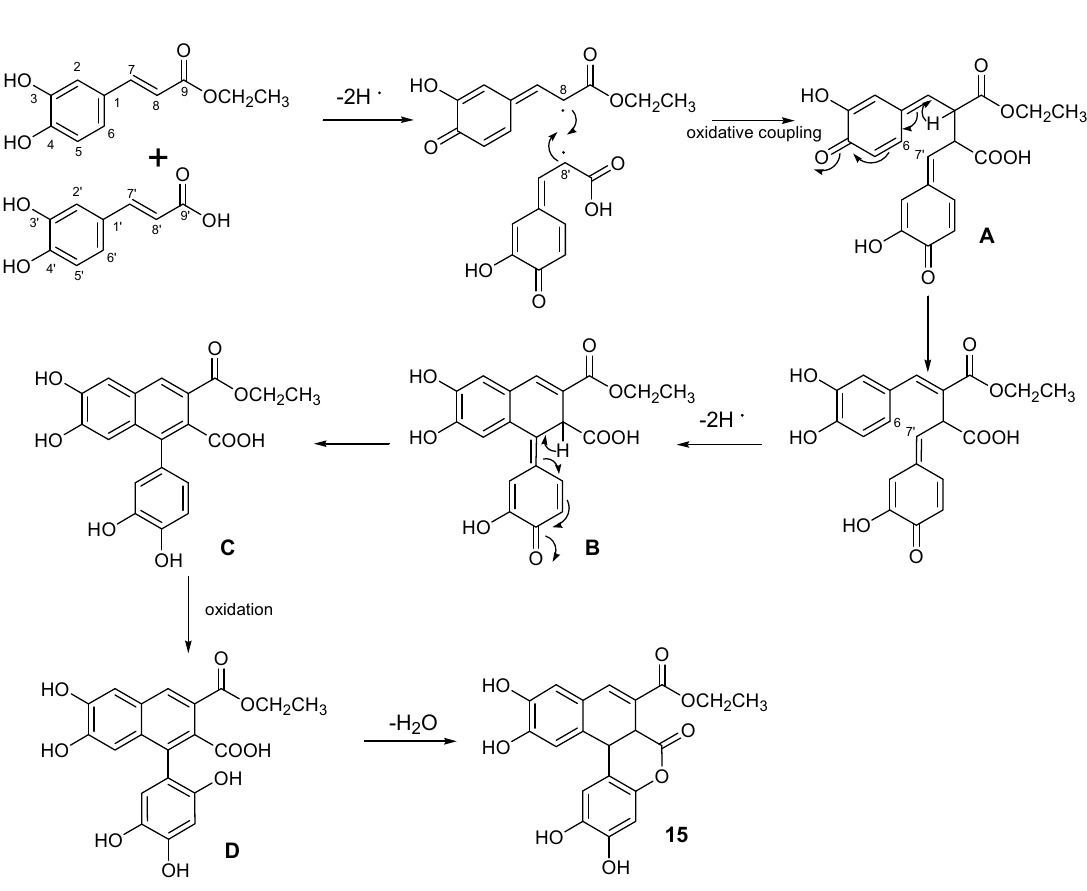
Figure 4. Proposed biosynthetic pathway for compound 15. Table 3. Inhibitory e ff ect of compounds 1 , 5 , 9 , 12 , 14 , 15 , and 16 on IL-1 β induced E-selectin expression.